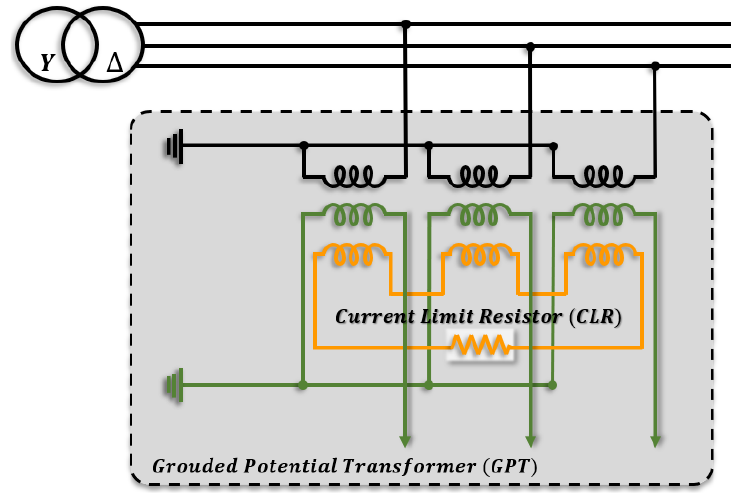
Figure 3. Configuration of ground potential transformer (GPT) connected ungrounded system.